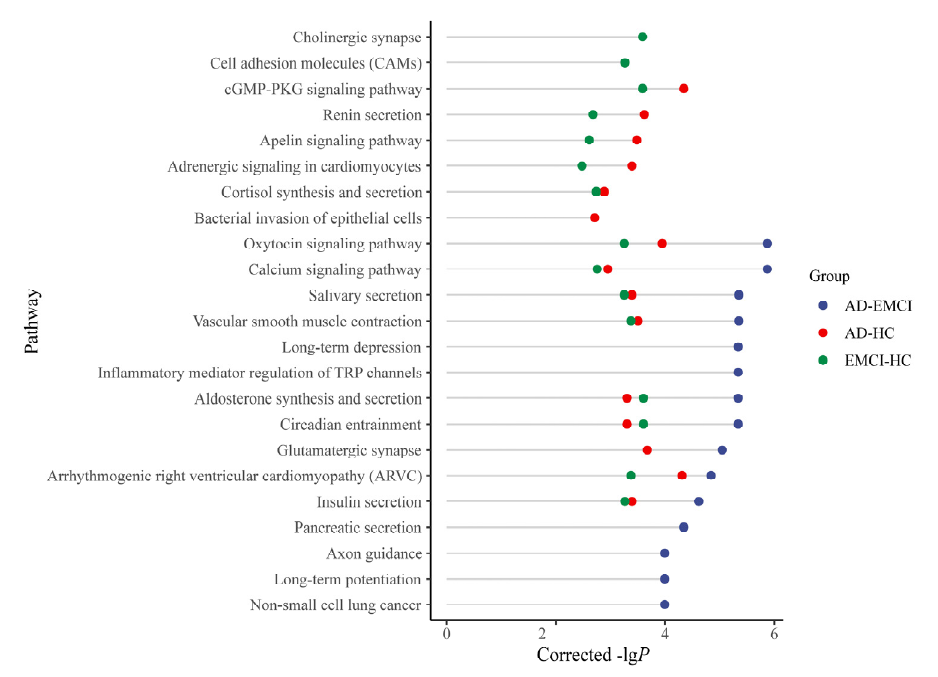
Figure 5. The top 15 pathways of the AD-HC group, AD-EMCI group and EMCI-HC